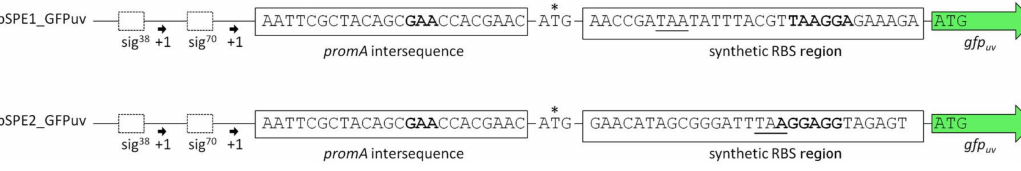
Figure 3. Schematic comparison of the promoter regions in plasmids pSPE1_GFPuv and pSPE2_GFPuv. Sequences in bold are the crucial bases involved in binding of the 16S rRNA as described by Schwibbert et al. [4] and as obtained by the RBS Calculator v2.0 [27,28]. The original start codon ATG (*) has little relevance in this context because of its weak RBS (GAA) and an in-frame stop codon further downstream